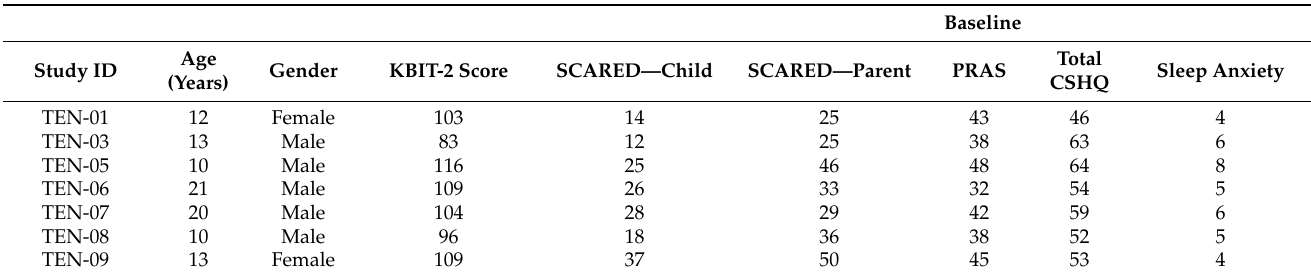
Table 1. Participant characteristics. Baseline Kaufman Brief Intelligence Test-2 (KBIT-2), child-rated Screen for Child Anxiety Related Disorders (C-SCARED), parent-rated Screen for Child Anxiety Related Disorders (P-SCARED), Parent-Rated Anxiety Scale (PRAS) and Total and Sleep Anxiety Score of the Children’s Sleep Health Questionnaire